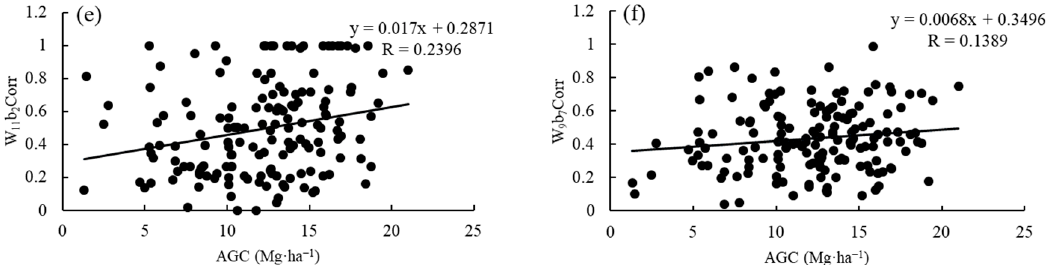
Figure 8. The AGC (Mg · ha − 1 ) versus eight variables derived from the AGC model of 2014: ( a ) AGC versus NDVI; ( b ) AGC versus W 3 B 7 Sec; ( c ) AGC versus W 3 B 5 En; ( d ) AGC versus TM 547 ; ( e ) AGC versus W 11 B 2 Sec; ( f ) AGC versus W 9 B 7 Corr. Table 7. The importance of the variables for the AGC estimation in different years.